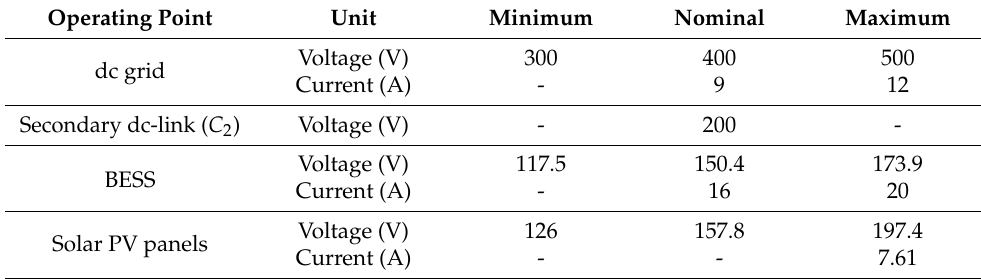
Table 1. Operating electric conditions of the proposed unified power